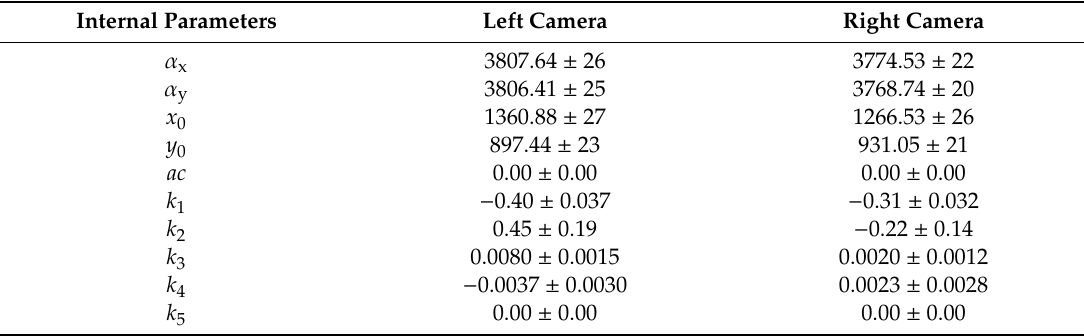
Table 1. Internal parameters and errors of binocular